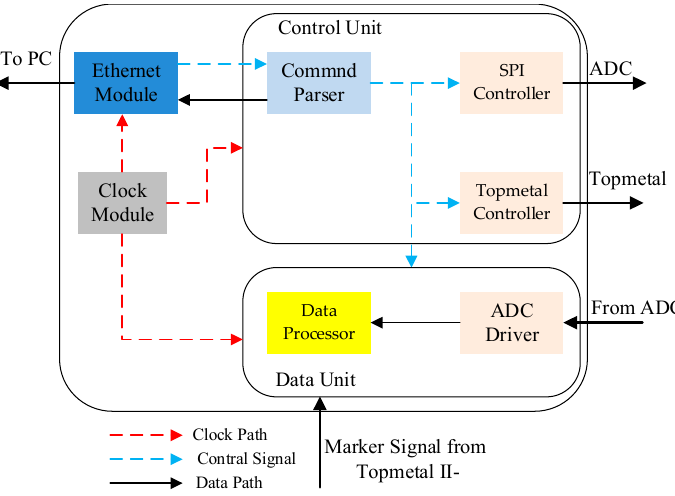
Figure 10. The diagram of the FPGA design.